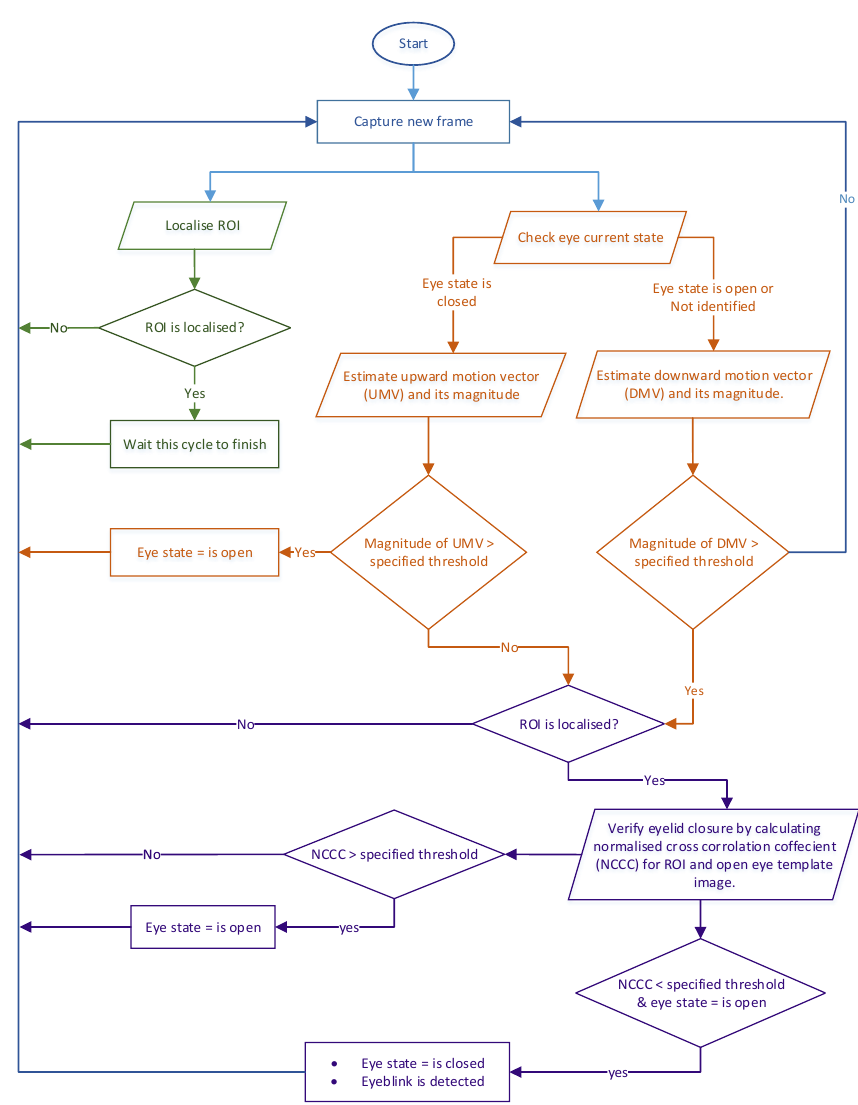
Figure 12. Eyeblink decision making logic diagram.